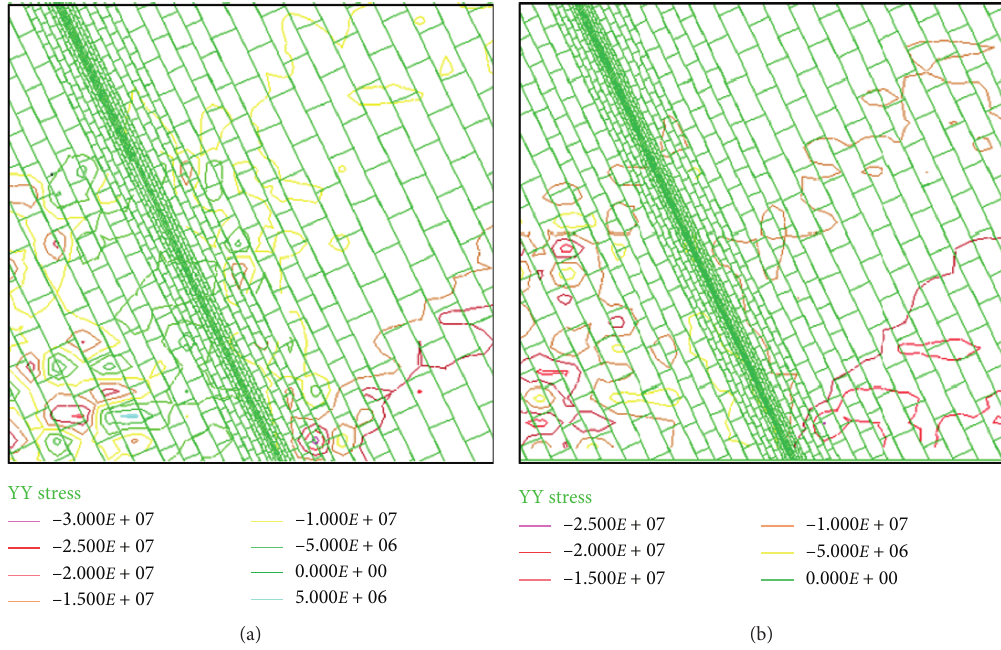
Figure 13: Surrounding rock vertical stress distribution with 200m stope height. (a) Caving. (b) Backfilling.